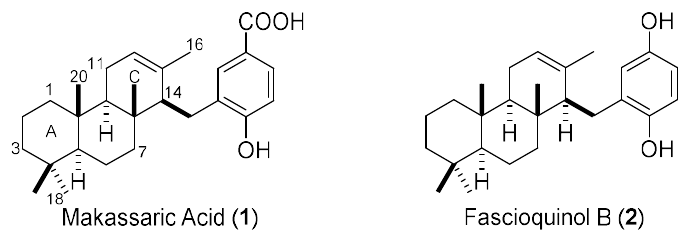
Figure 1. Chemical structures of makassaric acid ( 1 ) and fascioquinol B ( 2 ).